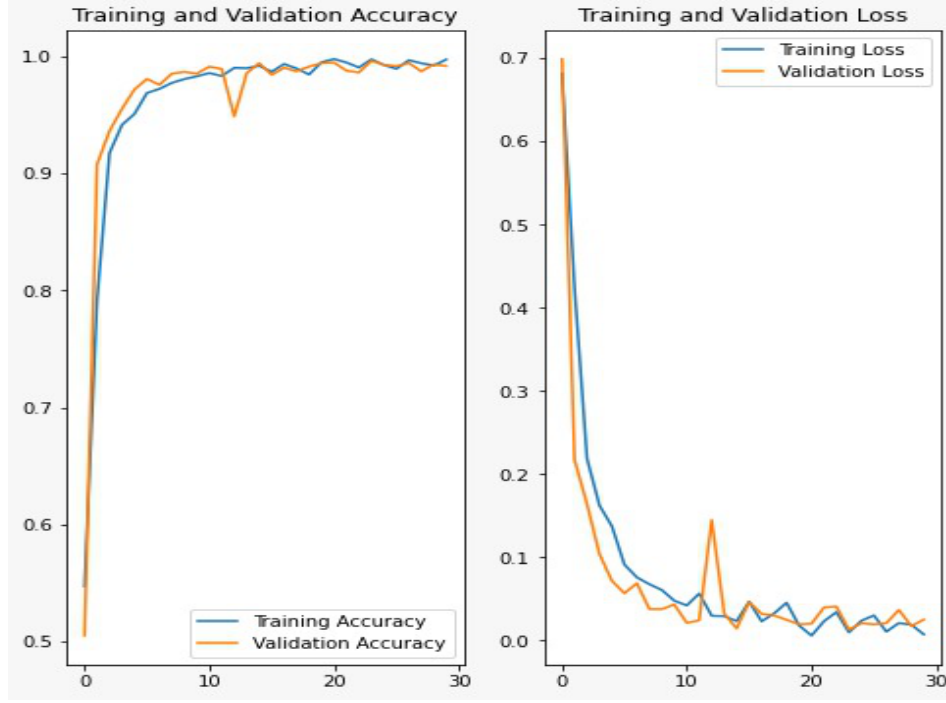
Figure 6. Accuracy and loss curves for training data and validation data during 30 epochs. Table 1. Comparison between the seven models (the best model with bold ).